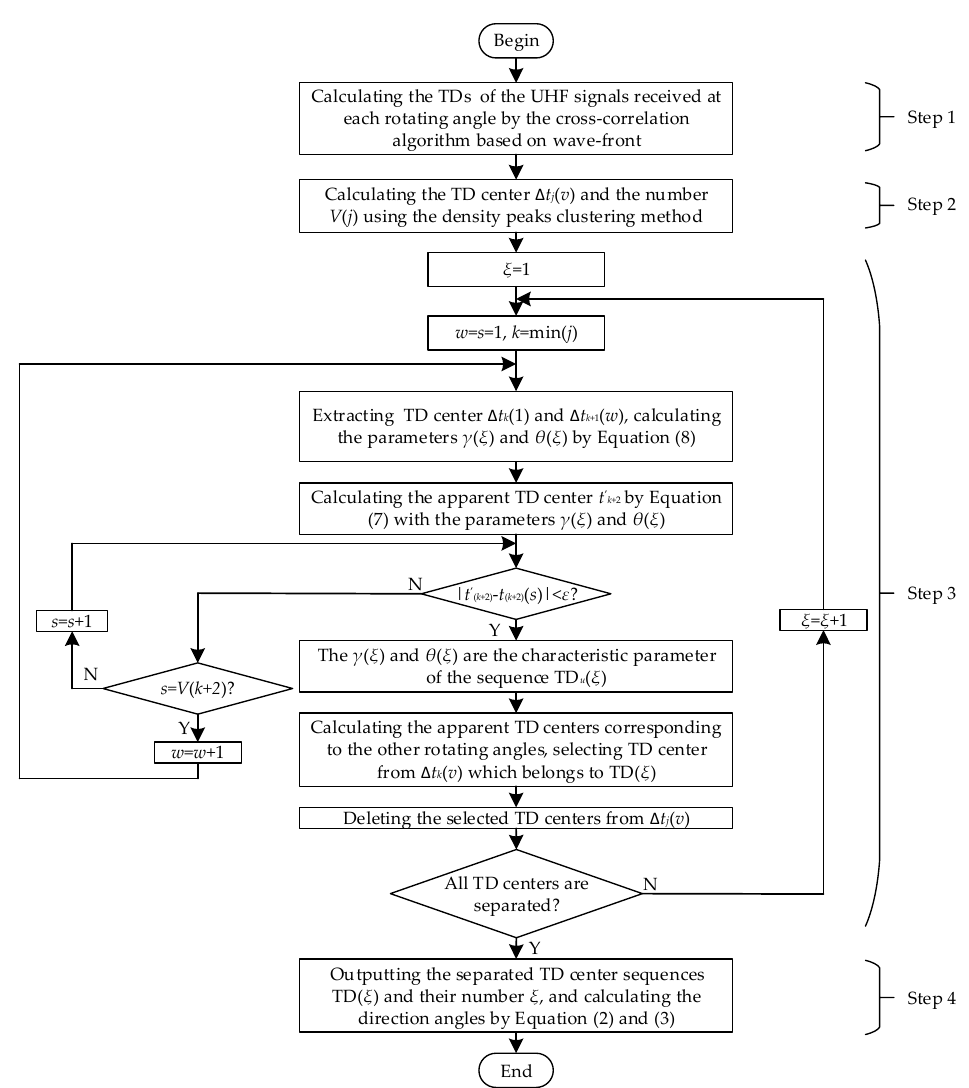
Figure 2. The separation method of the time delay (TD) sequences.